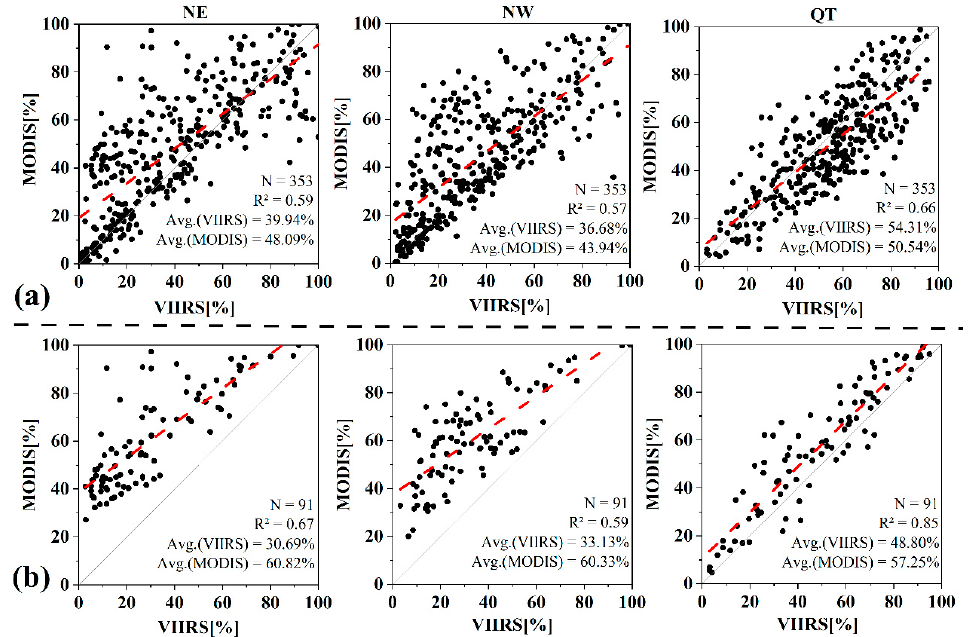
Figure 5. Scatter plots of daily CCPs in three test areas illustrating VIIRS with respect to MODIS in ( a ) the entire hydrological year and ( b ) the snow season. Each column represents the results in the NE, NW and QT regions from left to right. Avg. (VIIRS) represents the average CCP in VIIRS, and Avg. (MODIS) represents the average CCP in MODIS. The red line is the fitting line with the coefficient of determination (R 2 ), and N is the number of days.